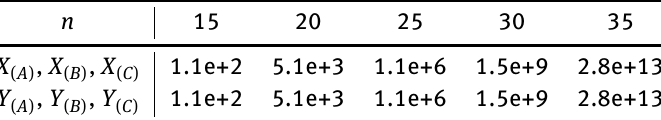
Table 7: Condition numbers of X ( A ) , X ( B ) , X ( C ) , Y ( A ) , Y ( B ) , Y ( C ) of T used in Table 4.